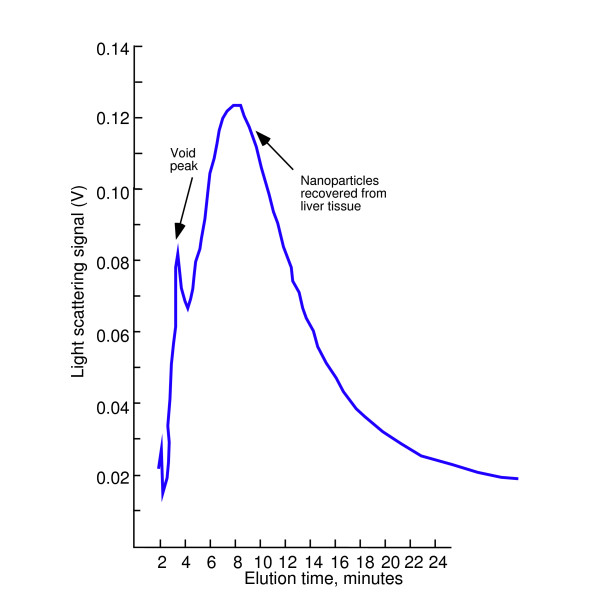
SdFFF fractogram of 70-nm SiO2 particles recovered from acid-digested rat liver.